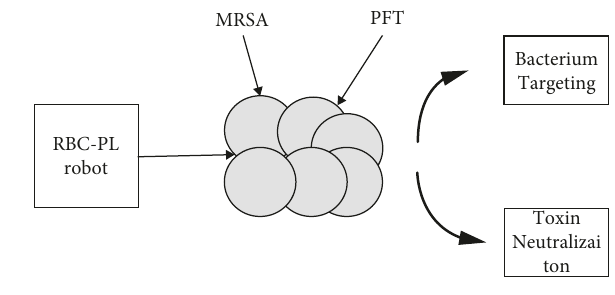
Figure 3: Hybrid RBC-PL robots.